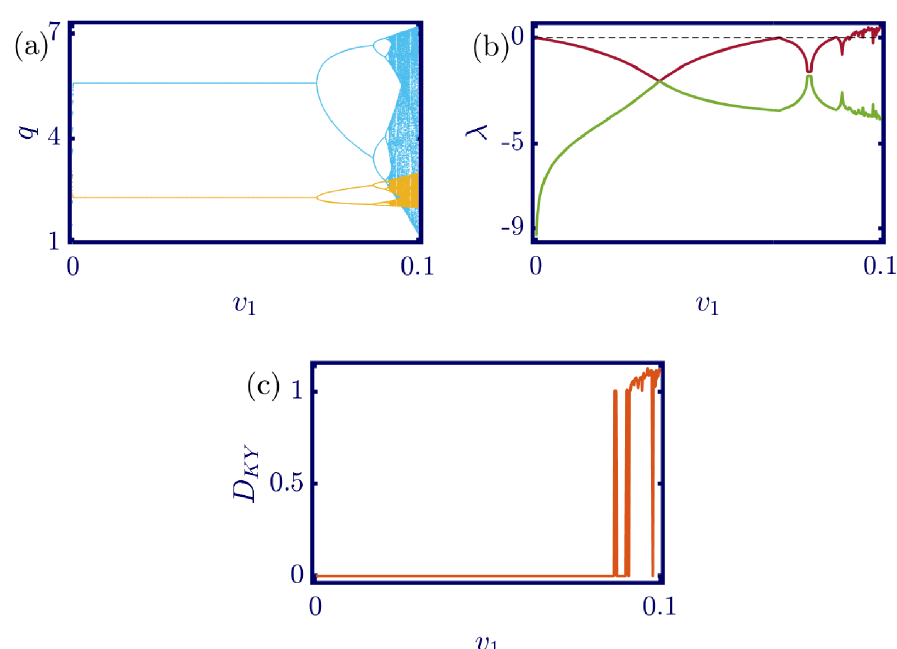
Fig 9. Eq (13) dynamics concerning the parameter v 1 with a = 6, b = 0.5, c 1 = 2, c 2 = 1, d 1 = 0.5, d 2 = 1, v 2 = 1 and initial conditions q 1 (0) = q 2 (0) = 1. (a) Bifurcation diagram, (b) Lyapunov exponents spectra, and (c) Kaplan-Yorke dimension. According to the period doubling route to chaos, smaller values of adaptation speed are desired for the leader firm. The leader firm should control the market, not vice versa. If the opposite occurs, it may lead to the unpredictability of the market. In the sub-figure (a), the cyan points represent the data for the leader firm ( q 1 ), whereas, the yellow points represent those for the follower firm ( q 2 ), and in sub-figure (b), the red and green points present the Lyapunov exponent spectra for the leader and follower firms respectively, namely λ 1 and λ 2 .